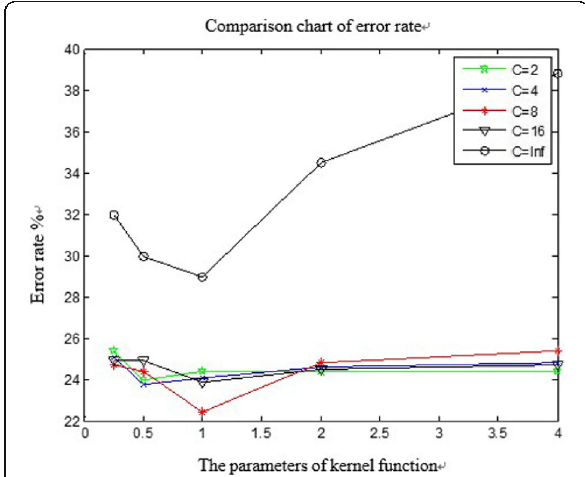
Fig. 17 Error rate with different Rbf parameters